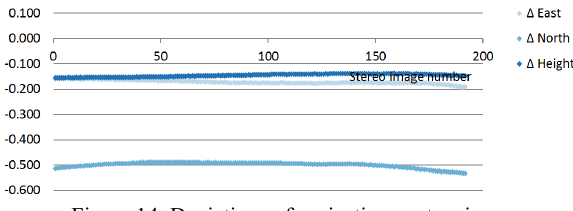
Figure 14. Deviations of projection centers in m for sequence